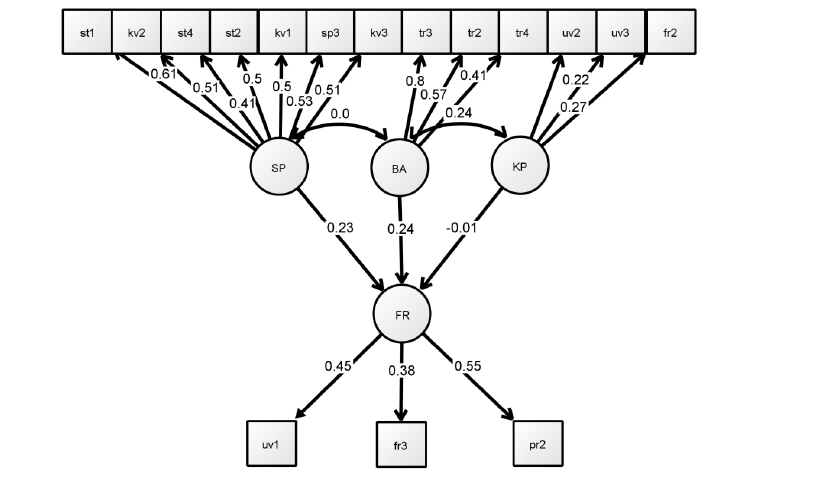
Fig. 3 - Structural model –females’ sample. Source: own All models were probed by standard fit performance indicators. A test based on Chi statistics rejects the null (the observed and theoretical covariance matrices are the same). This finding speaks against the quality of the model as the simplification made by the structural model (re- moval of some connections between variables). The comparative fit is also not high. This is, however the problem of the overall design (e.g., identification of factors, imprecise questions) which cannot be attributed to subsample analysis. Absolut fit indicators RMSEA and SRMR are almost